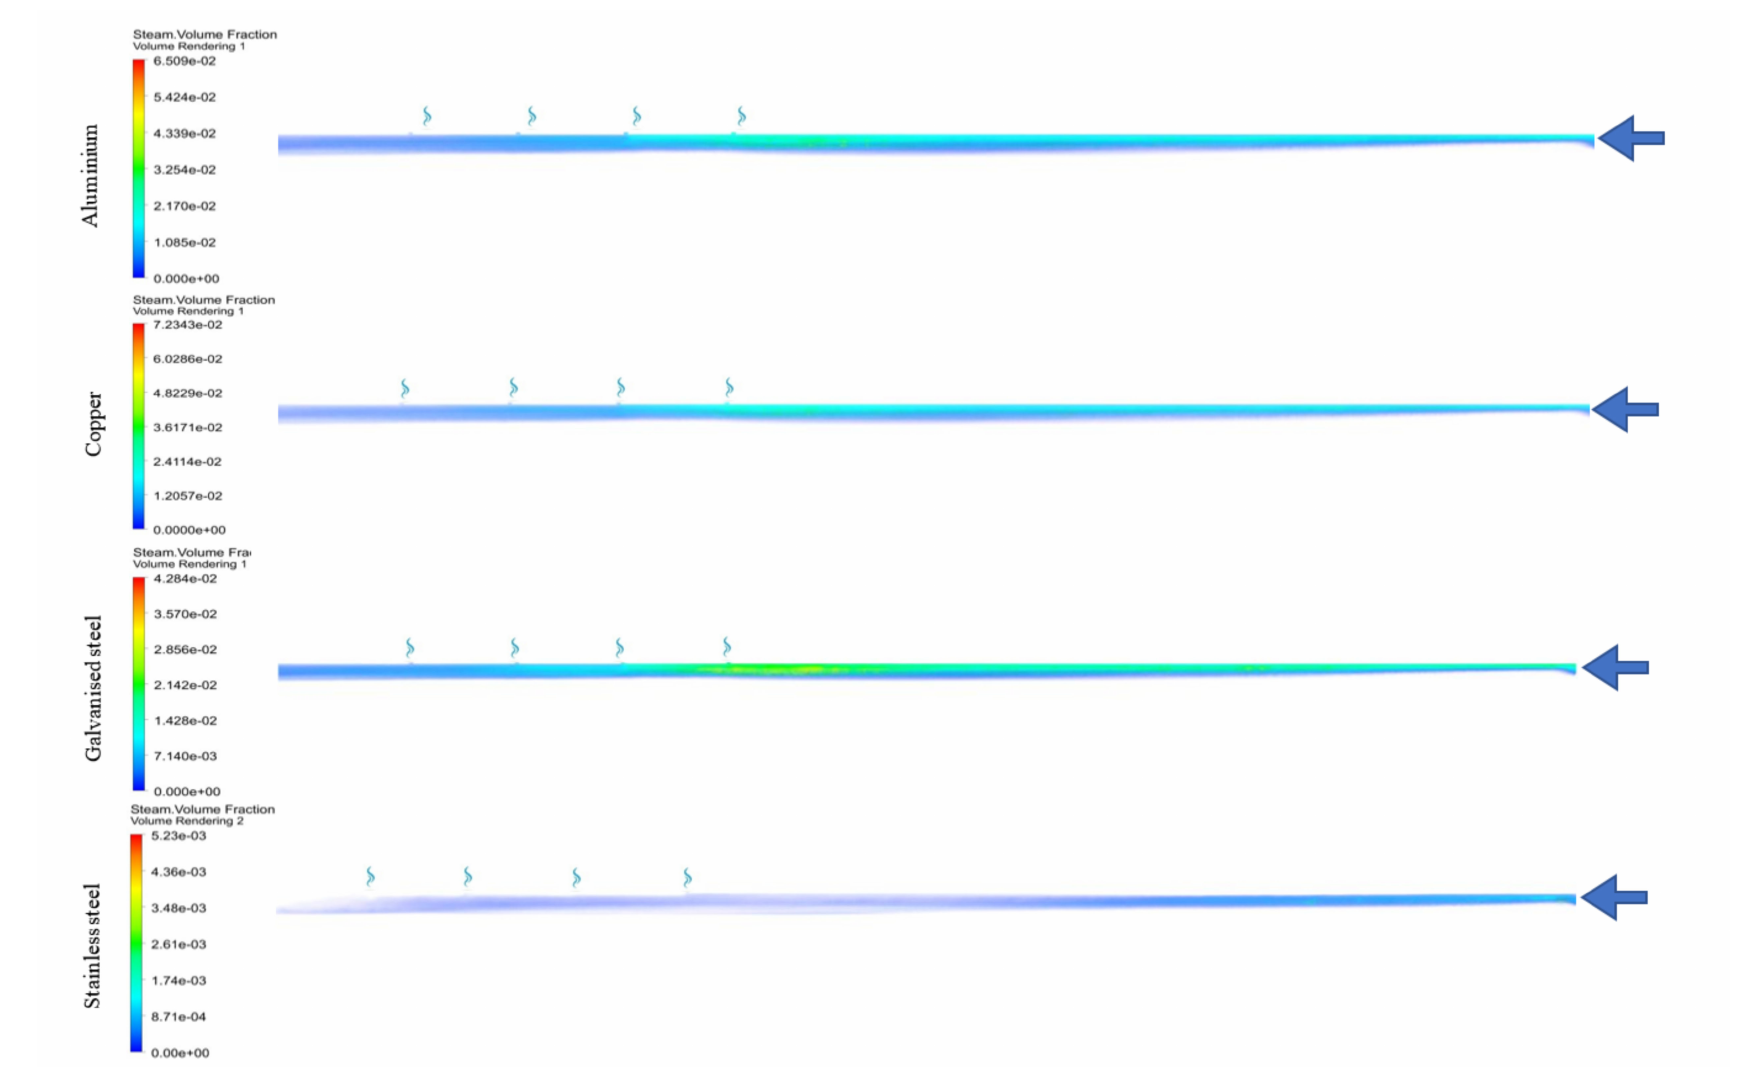
Figure 8. Vapour volume fraction contours corresponding to an outer surface temperature of 100 ◦ C for di ff erent receiver tube